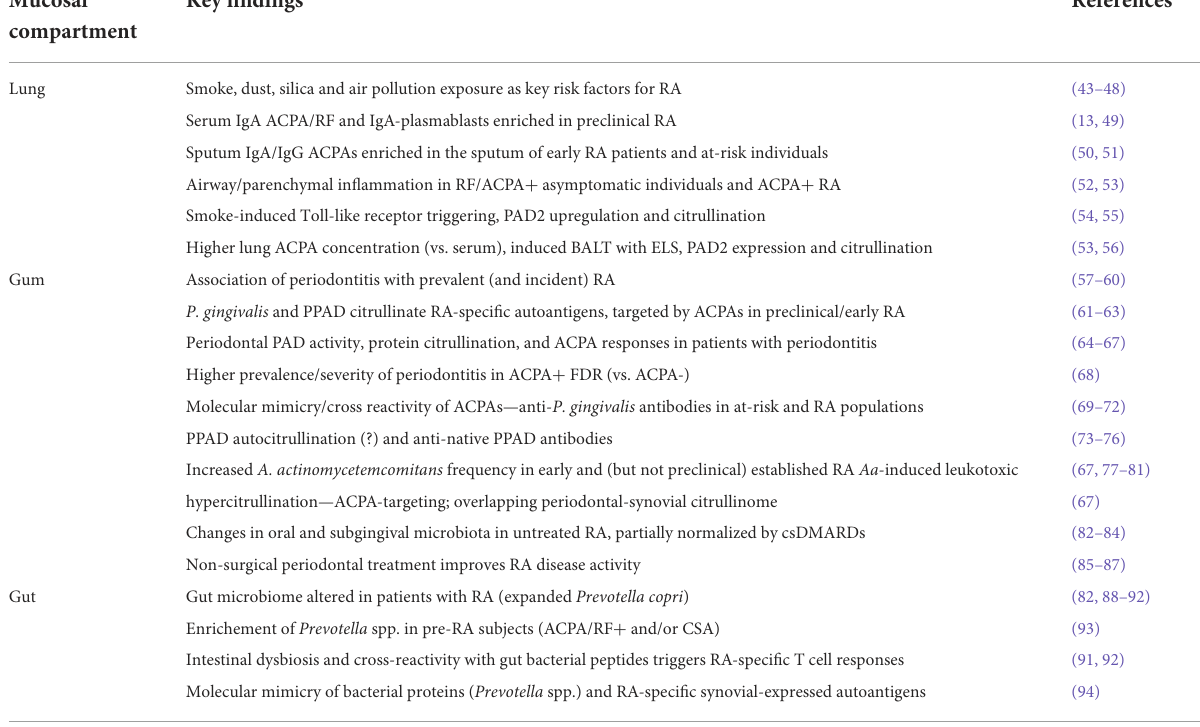
TABLE 1 Main findings and possible mechanisms supporting a mucosal triggering of autoimmunity in